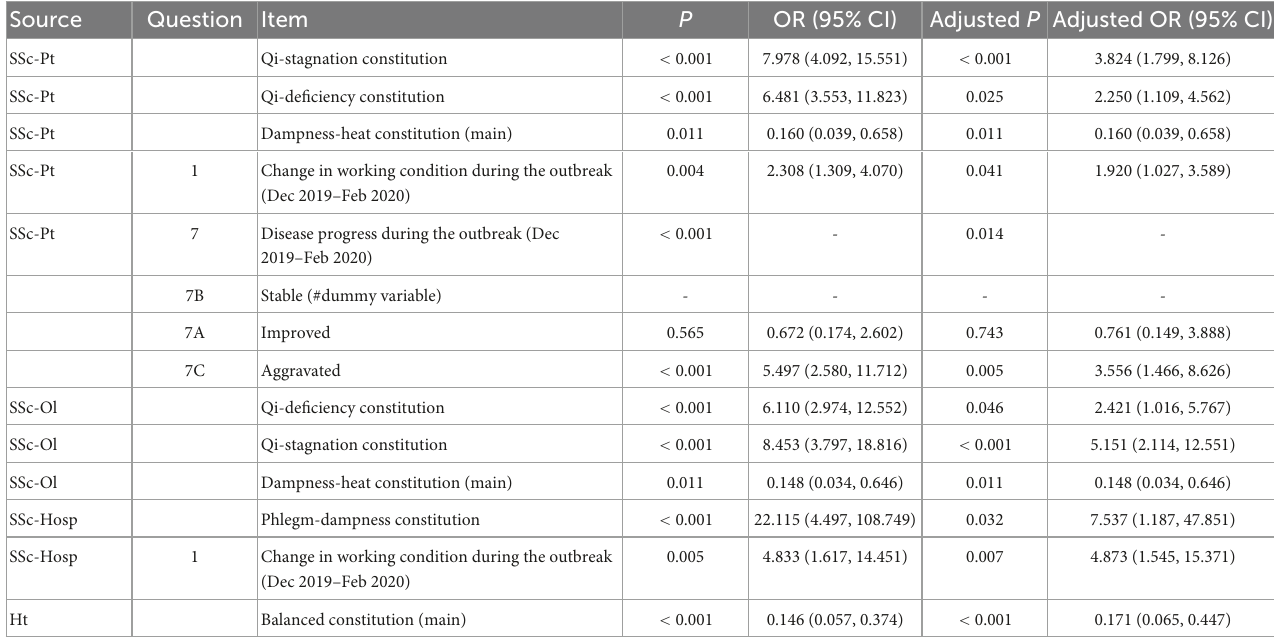
TABLE 2A Regression analysis of related factors of depression, anxiety, and suicidal ideation (Depression).